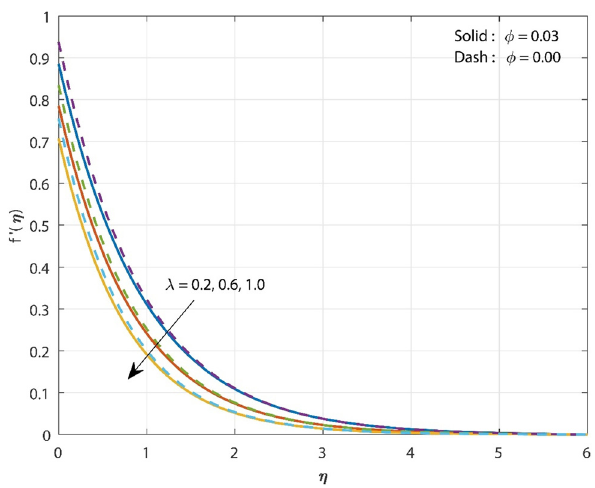
Figure 2: Plot of f ′ ( η ) over di ff erent values of λ